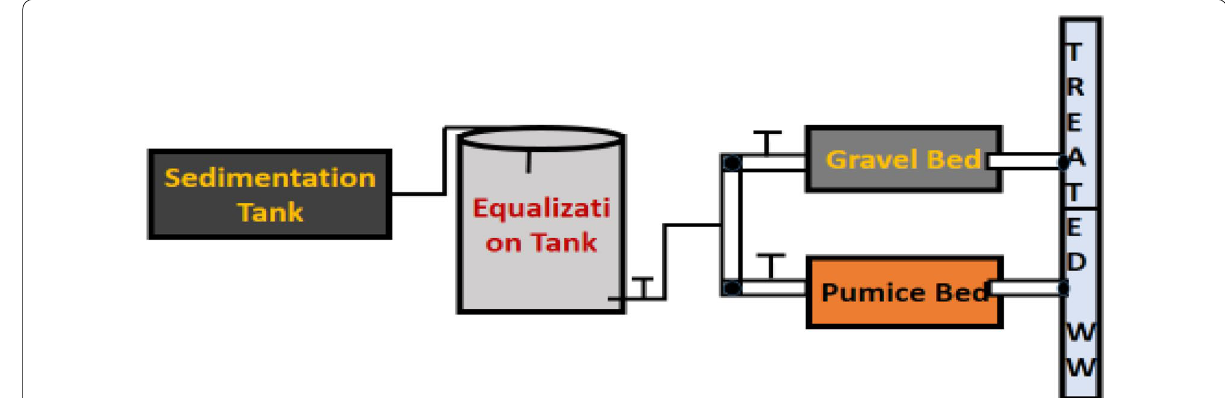
Fig. 2 Schematic diagram of the horizontal subsurface constructed wetland